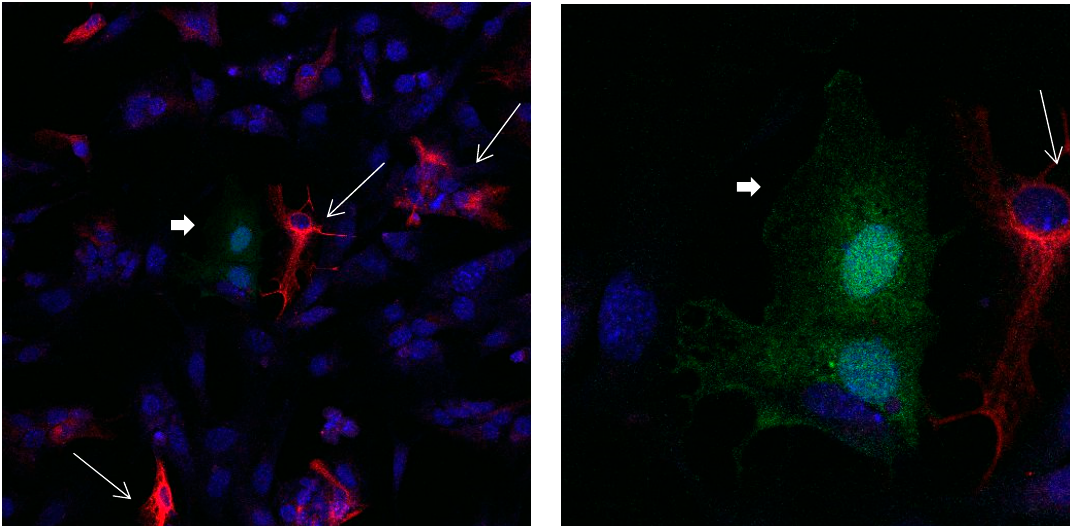
Figure 1. Cultures in a serum-containing medium, 1 day after passage: Immunofluorescence with anti-GFAP (glial fibrillary acidic protein) (red, secondary antibody: donkey anti-goat IgG Alexa Fluor 594), and with anti-Calbindin D28k (polyclonal antibody from the company SWANT) (green, secondary antibody: donkey anti-rabbit IgG Alexa Fluor 488); Nuclear staining with DAPI (4 ′ ,6-diamidino-2-phenylindole dihydrochloride) (blue). Confocal microscopy. Left : zoom = 1, numerous GFAP-positive astrocytes (long arrows), in between 2 Calbindin D28k positive and GFAP-negative astrocytes (short arrows). Right : zoom = 4, higher magnification of the 2 Calbindin D28k positive astrocytes (short arrows).